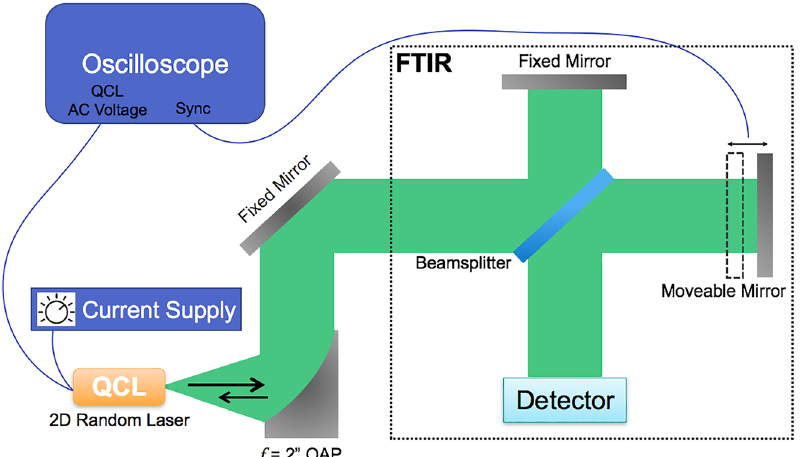
Figure 2: Diagram of self-mixing experi- mental setup. A Fourier transform infrared spectrometer (FTIR) simultaneously allows acquiring the emission spectra and measuring the self-mixing signal, by employing the mirror in the moving arm to vary the path-length for the light back- scattered to the laser.